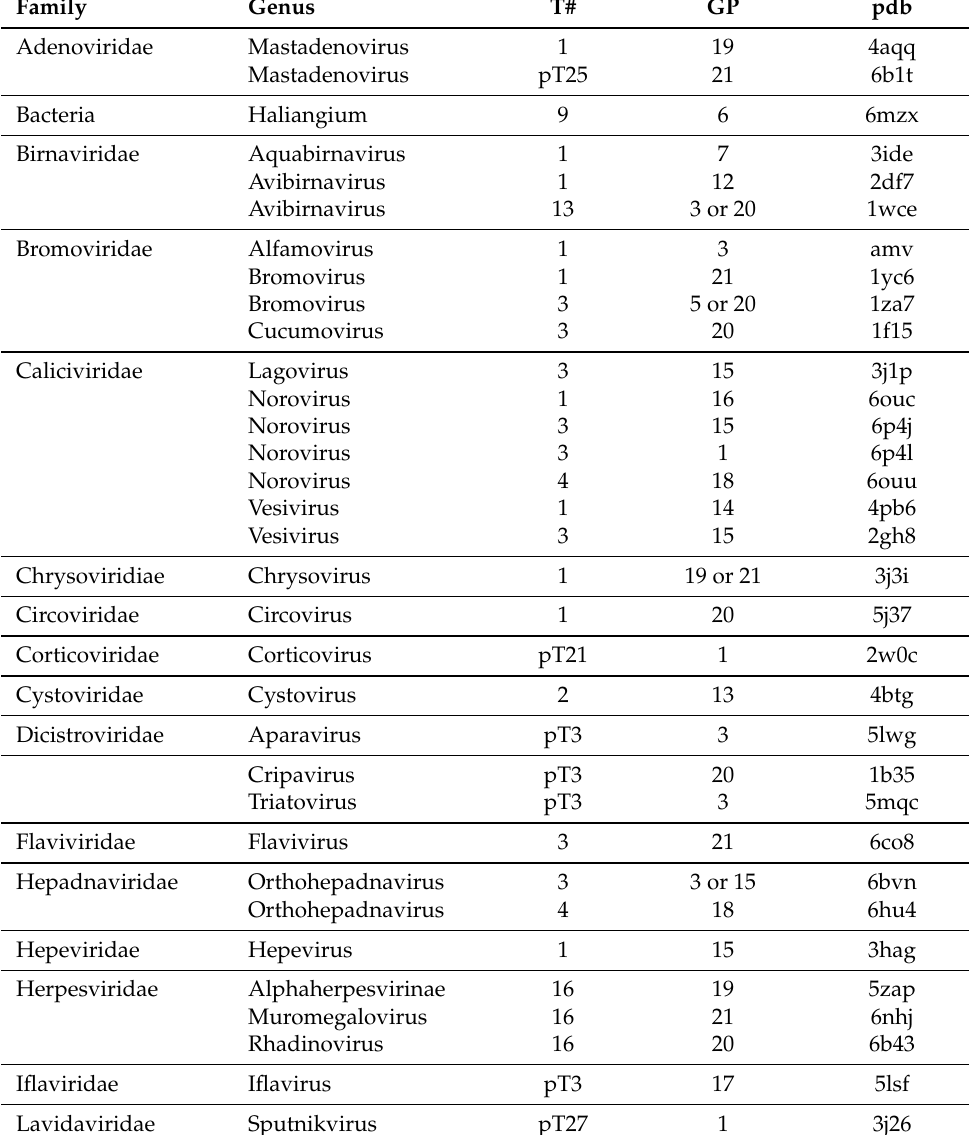
Table A1. Viral Capsid Library—here are the 135 distinct capsid with unique families, genera, Triangulation numbers and lowest resolutions. When there was a tie for lowest resolution, both structures were used. Resolution ties accounted for 6 additional